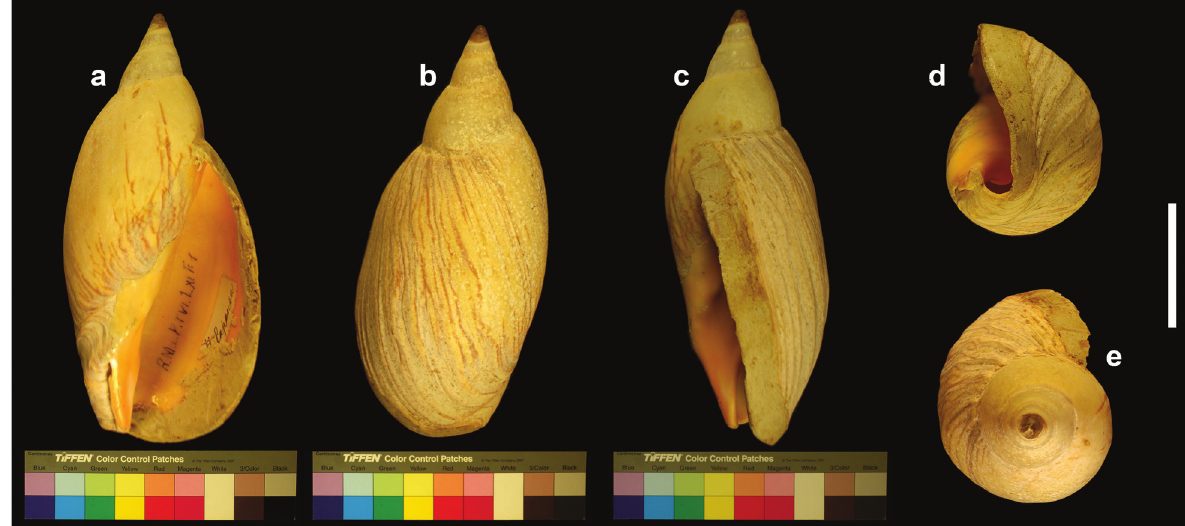
Figure 10. Voluta ancilla expansa , specimen figured by Lahille. a Apertural view b Dorsal view c Lateral view d Umbilical view e Apical view. Scale bar: 5 cm.